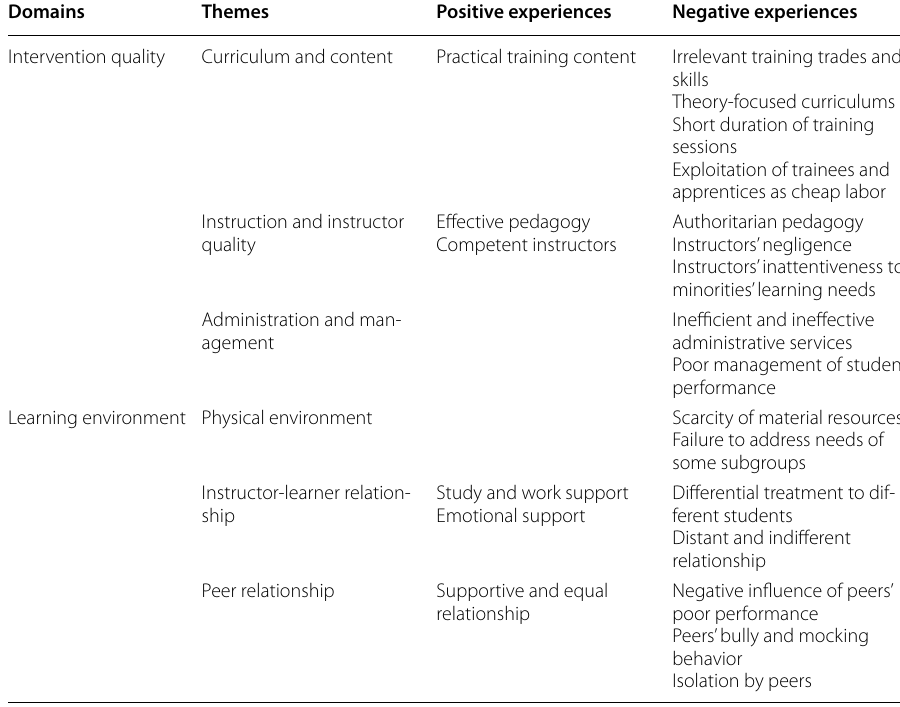
Table 3 A Summary of Young People’s Learning Experiences